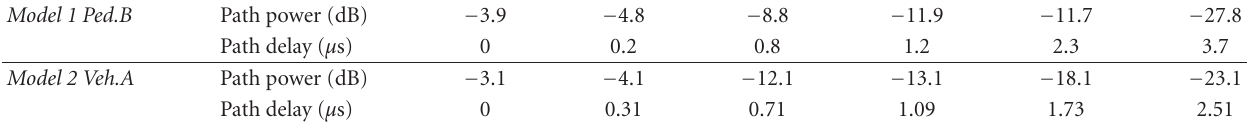
Table 2: Profiles of channels used in